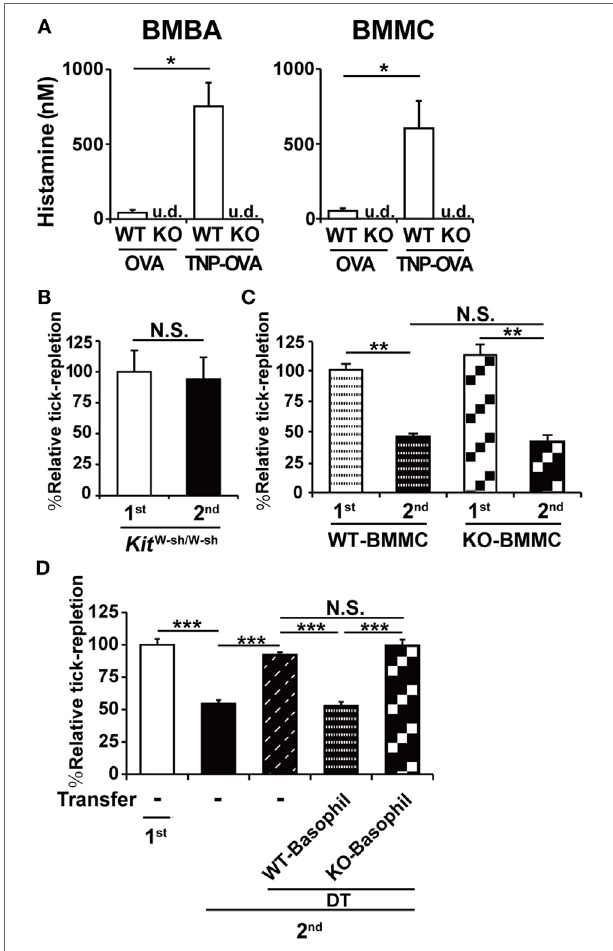
FigUre 3 | Histamine derived from basophils but not mast cells is crucial for the manifestation of acquired tick resistance. (a) Bone marrow-derived basophils and bone marrow-derived mast cell (BMMCs) generated from WT or histidine decarboxylase (HDC) KO mice were sensitized with anti- trinitrophenol (TNP)-immunoglobulin E and then stimulated with TNP-OVA or control OVA. The concentration of histamine released into culture medium is shown (mean ± SEM, n = 3). u.d., undetected (B) Mast cell-deficient Kit W-sh/W-sh mice were infested once or twice with ticks. The relative tick repletion is shown (mean ± SEM, n = 3 each), in that the value in the first infestation was defined as 100%. (c) BMMCs prepared from WT or HDC KO mice were intradermally administered into the right flank of Kit W-sh/W-sh mice. One group (first) of the recipient mice were infested once with tick larvae on the BMMC-injected site 6 weeks after the transplantation. The other group (second) was infested twice with larvae, first on the left flank 4 weeks after the BMMC transplantation, and 2 weeks later, re-infected with larvae on the BMMC-injected site of the right flank. The relative tick repletion in each group is shown, in that the value in the first infestation was defined as 100% (mean ± SEM, n = 3–4). (D) Mcpt8 DTR mice were infested once (first) or twice (second) with tick larvae. To deplete basophils during the second infestation, they were treated with intravenous injection of diphtheria toxin (DT) 1 day before the second infestation. To reconstitute basophils, basophils